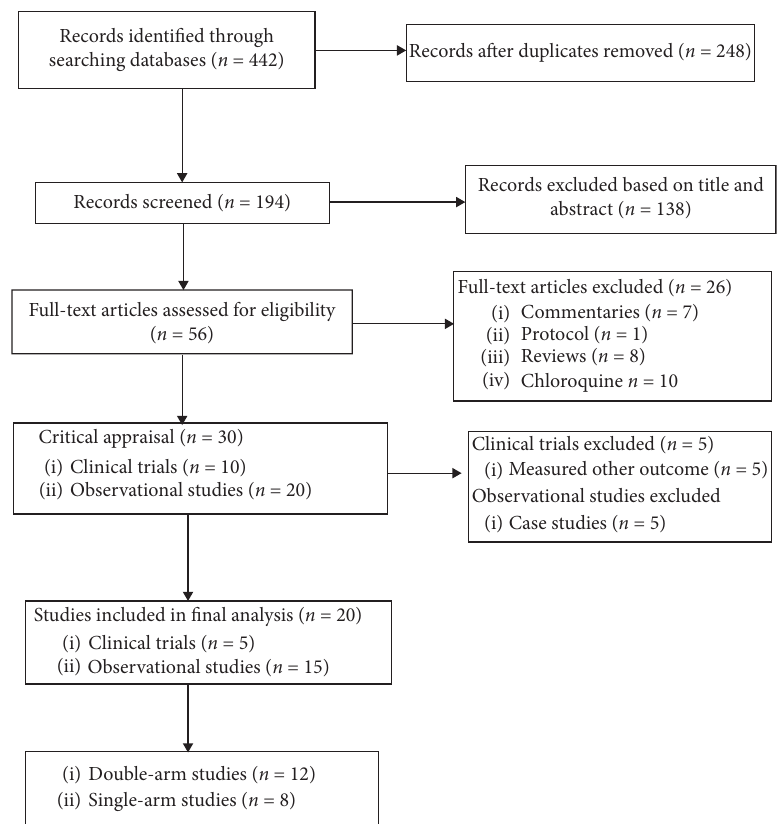
Figure 1: The Preferred Reporting Items for Systematic review and Meta-Analysis (PRISMA) flow chart for the included